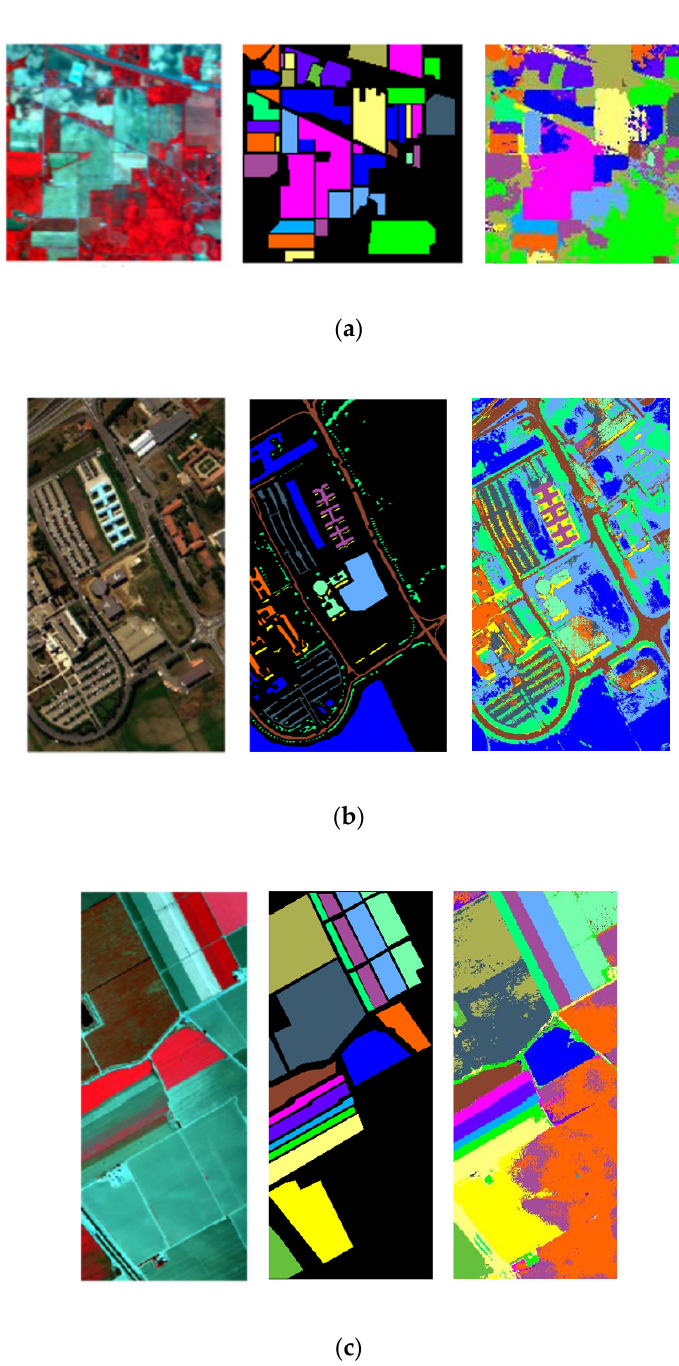
Figure 7. The false color composite image, the ground truth image, and the INAPC classification map of the three datasets. ( a ) Indian Pines; ( b ) Pavia University scene; ( c ) Salinas scene.